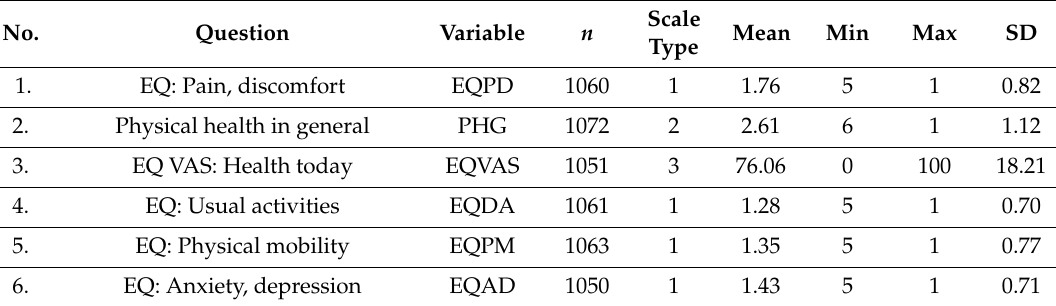
Table 1. Variables from the survey used in this